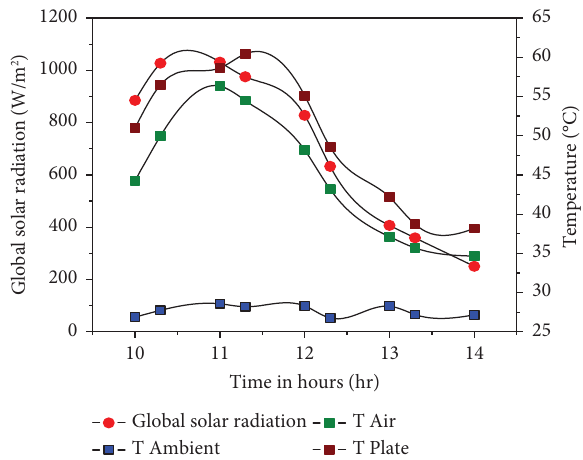
Figure 6: Te profles of temperature and solar intensity during solar drying of